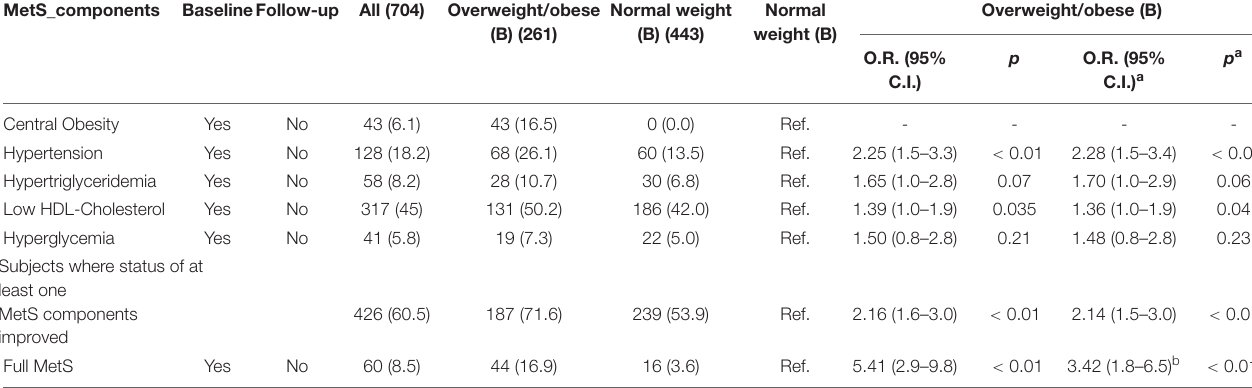
TABLE 5 | Age-adjusted odds of the positive change in status of MetS and its components post intervention in participants with “overweight/obese” compared to the normal. MetS_components BaselineFollow-up All (704) Overweight/obese (B)